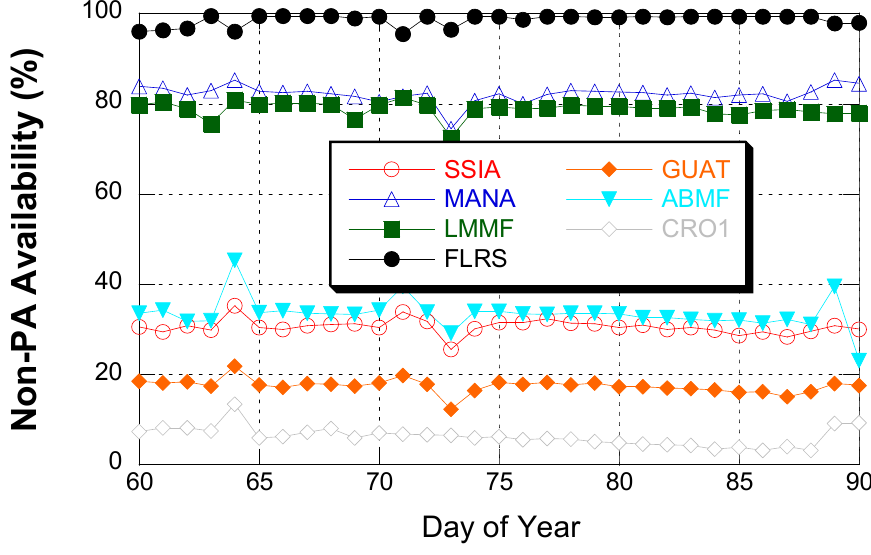
Figure 4. Non-precision approach (NPA) availability variation at seven selected IGS stations in March 2015.